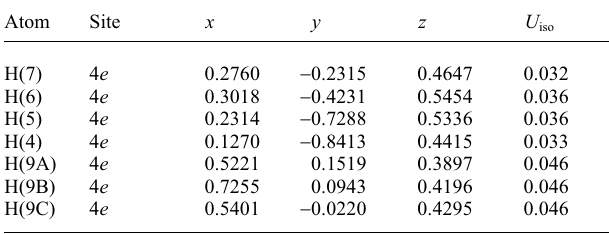
Table 2. Atomic coordinates and displacement parameters (in Å 2 ) .